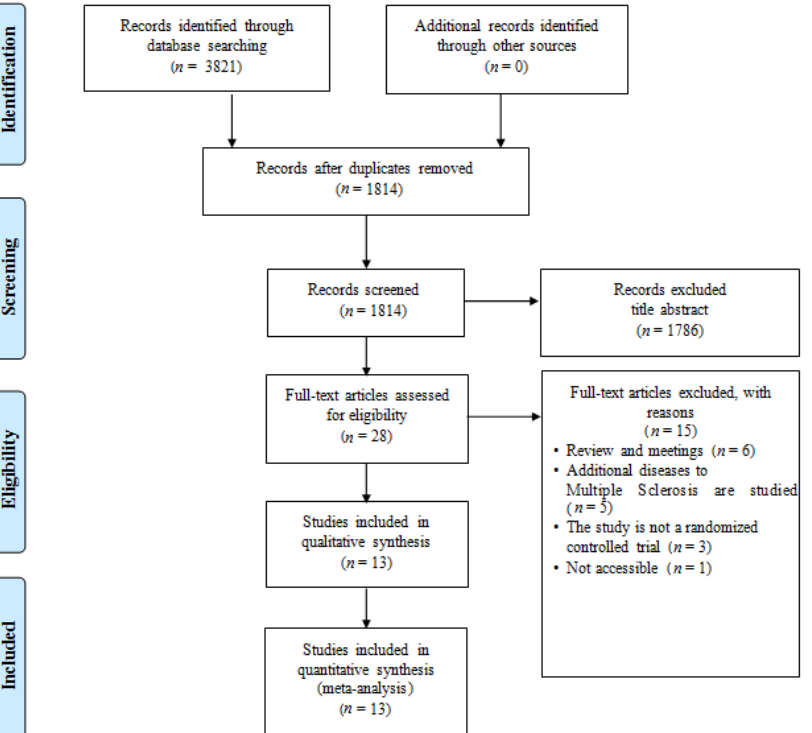
Figure 1. PRISMA flowchart of publication search. The diagram comprises eligibility, screening, article identification, and final inclusion.